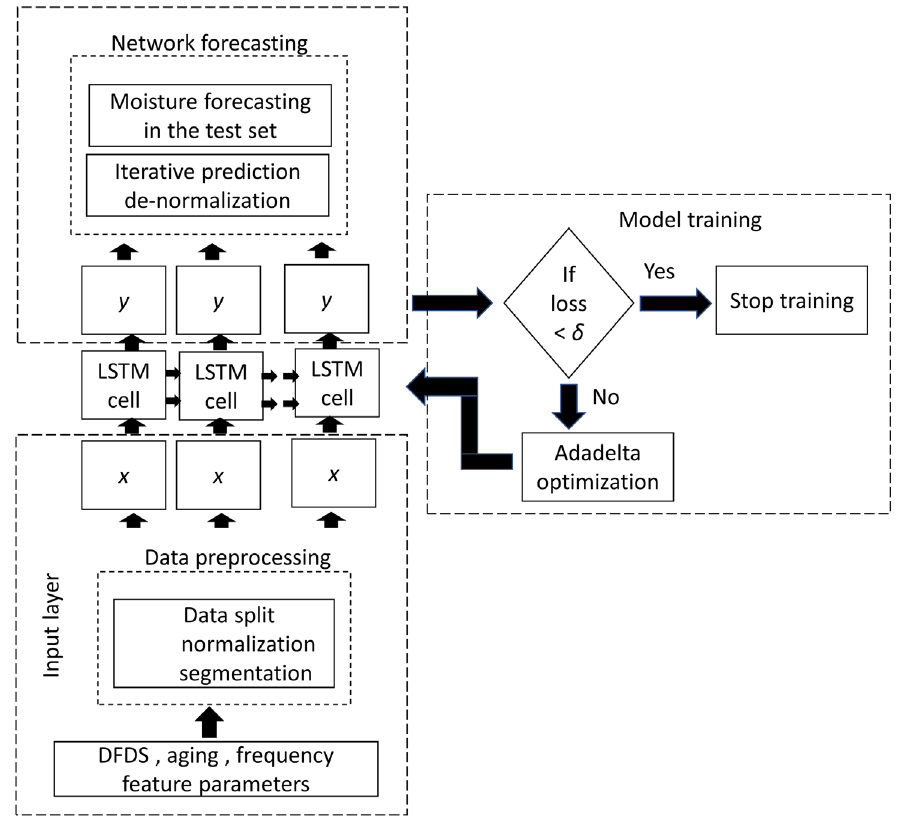
Figure 5. The flowchart of the moisture diagnosis algorithm.